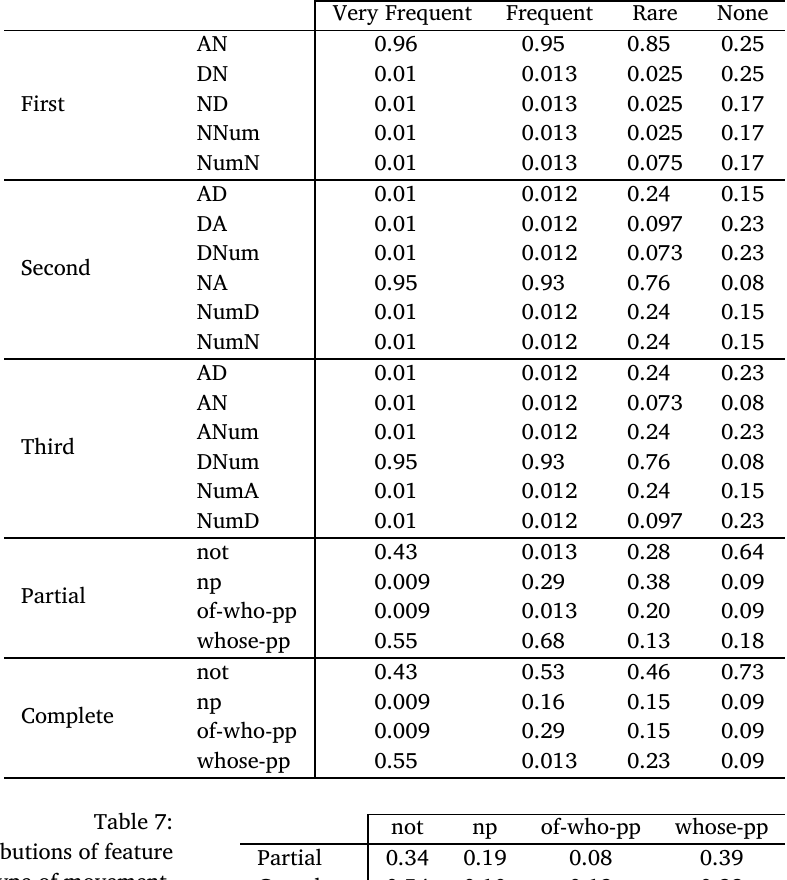
Probability distributions of feature values by type of